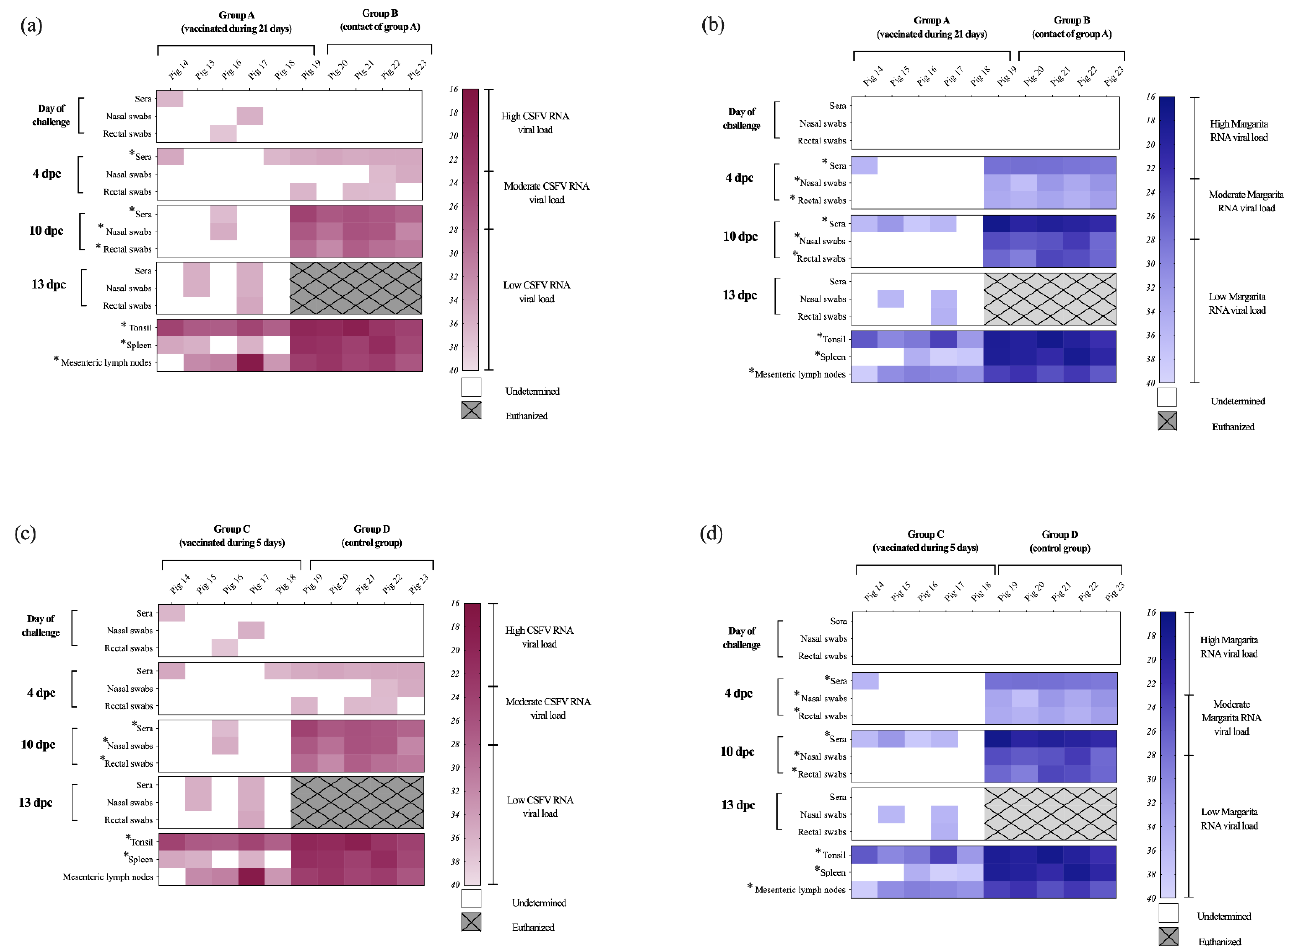
Figure 6. CSFV RNA detection at different time points after challenge in samples and tissues. The samples were analyzed by RT-qPCR for ( a , c ) the CSFV [24] and ( b , d ) Margarita strain RNA [20] viral load at different time points during the 13 dpc (or until euthanasia). White area indicates negative samples. Euthanized animals are represented in grey square with hatches. Asterisk symbol (*) indicates statistically significant differences of the Ct values between the groups ( p < 0.05).